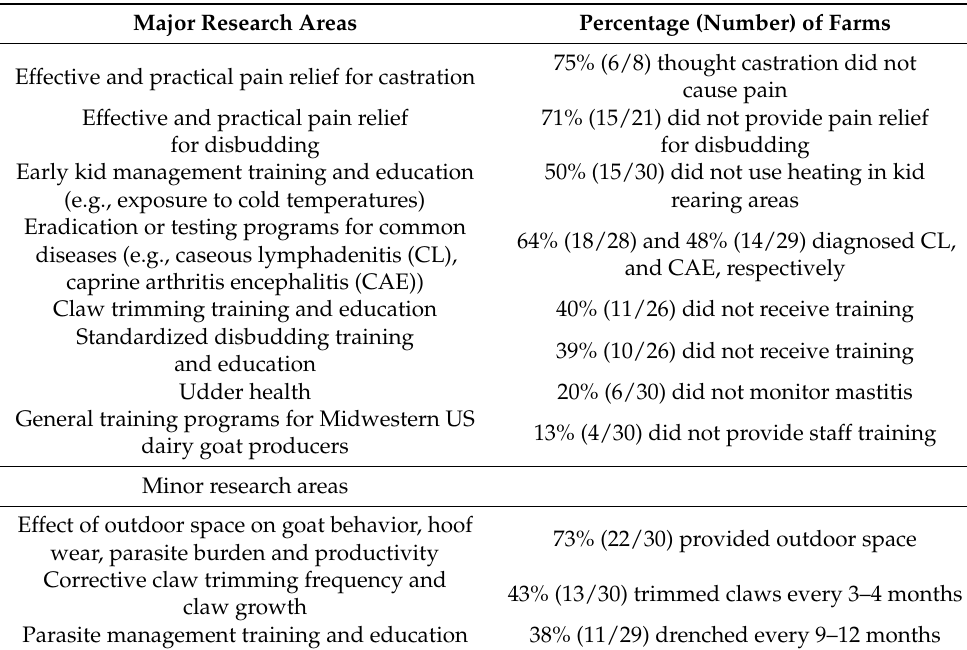
Table 9. Summary of the key areas of research for the Midwestern US dairy goat industry. The summary is arranged based on the percentage of producers (highest to lowest) that responded as not performing (major) or performing (minor) various husbandry